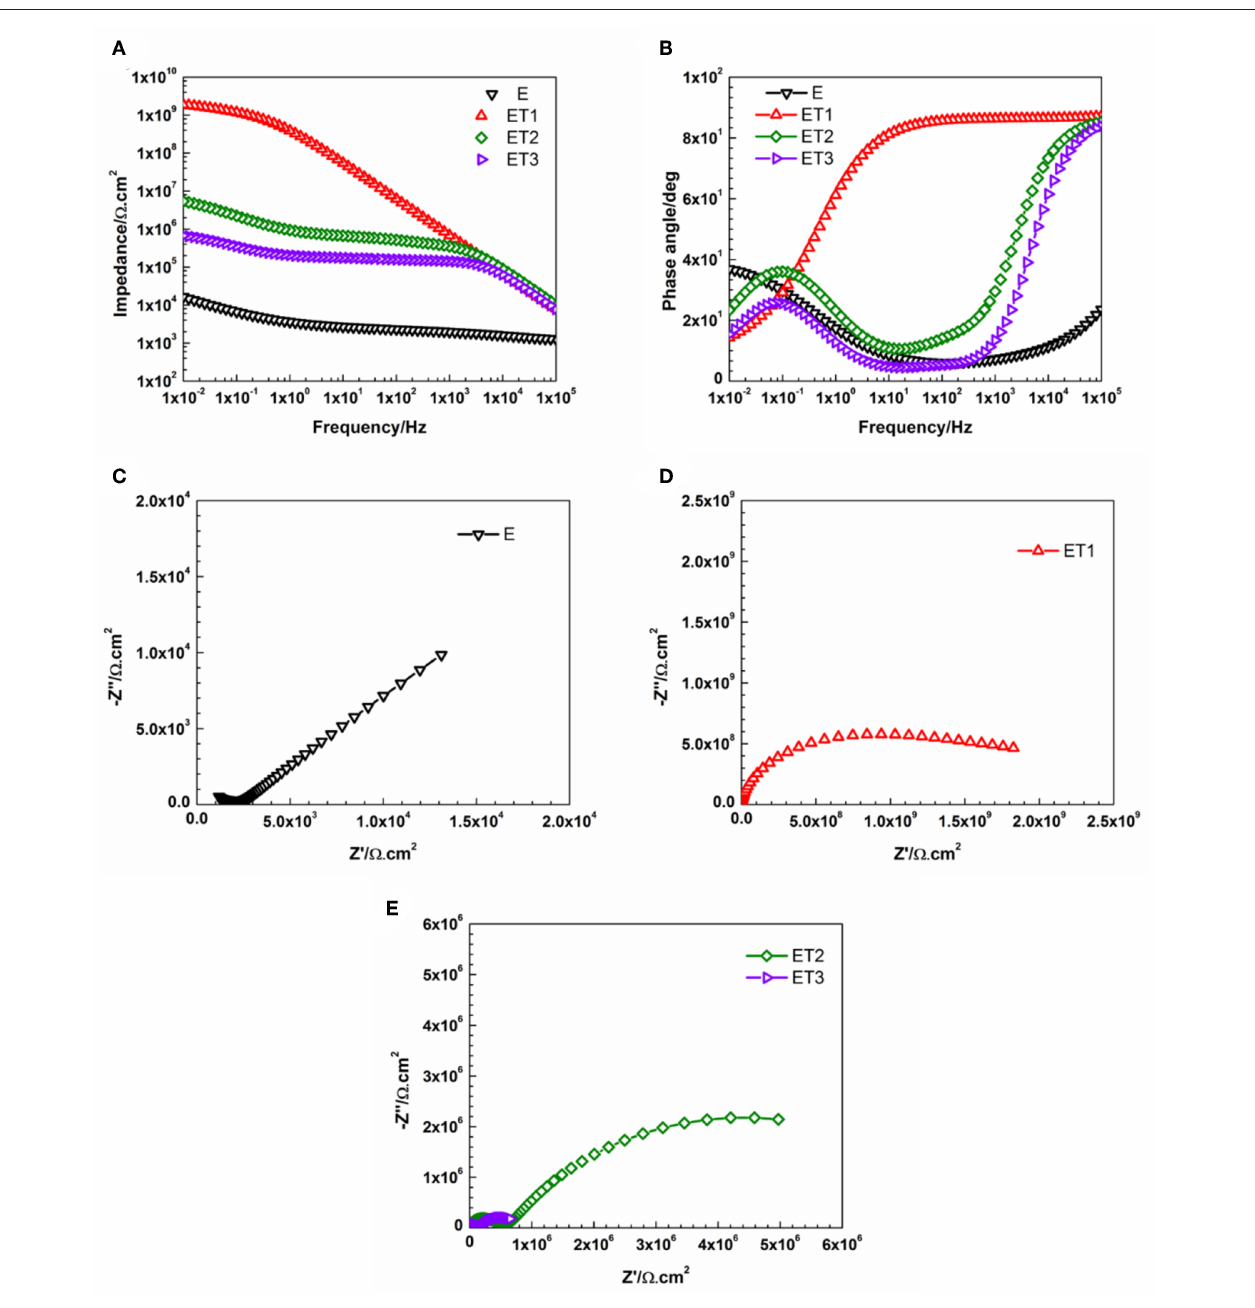
FIGURE 9 | Representative (A) Bode plots and (B) phase angle plots for all prepared epoxy-based coating systems, (C) Nyquist plot for E coating system, (D,E) Nyquist plots for all epoxy-TiO 2 nanocomposite coating systems after 30 days of immersion.